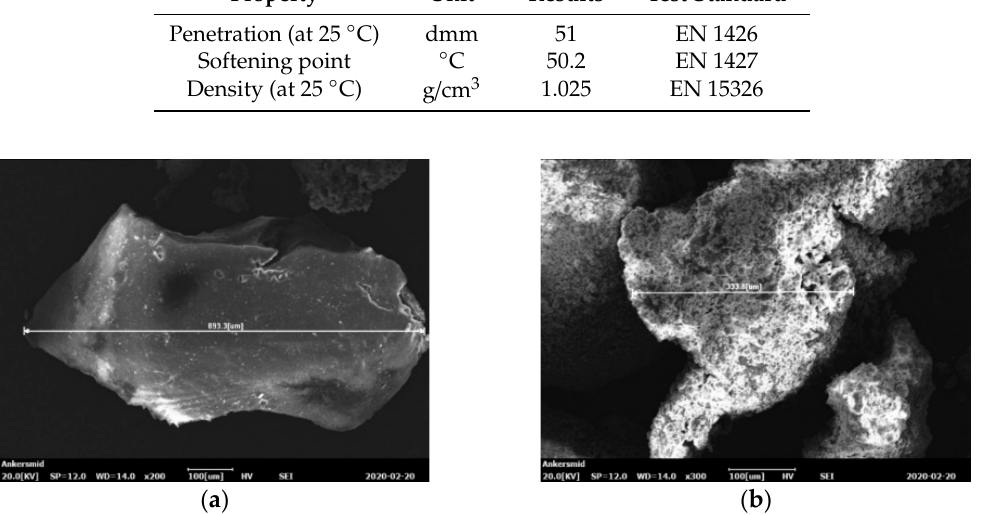
Figure 1. Scanning electron microscopy images of the crumb rubber (CR) particles: ( a ) CR1 and ( b ) CR2.